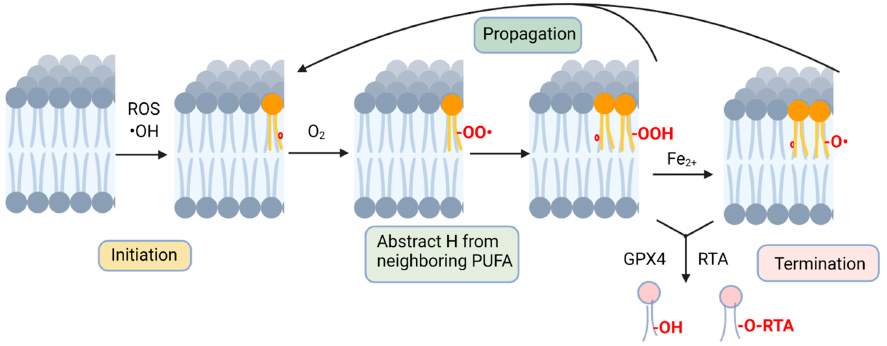
Figure 1. Non-enzymatic lipid peroxidation. Peroxidation is initiated by cellular ROS, where hydroxyl, alkoxyl or peroxyl radicals abstract a hydrogen from a PUFA acyl group (radical electrons denoted as red circle). A PUFA peroxide is formed by reacting with molecular oxygen and abstraction of a hydrogen from an adjacent membrane PUFA. Fenton chemistry contributes to further lipid radical formation, contributing to the chain reaction of lipid radicals attacking acyl groups on nearby unsaturated phospholipid molecules. Lipid peroxidation is terminated by actions of radical-trapping antioxidants or by reduction by catalyzed by glutathione peroxidase activity. Figure created with BioRender.com, accessed on 1 February